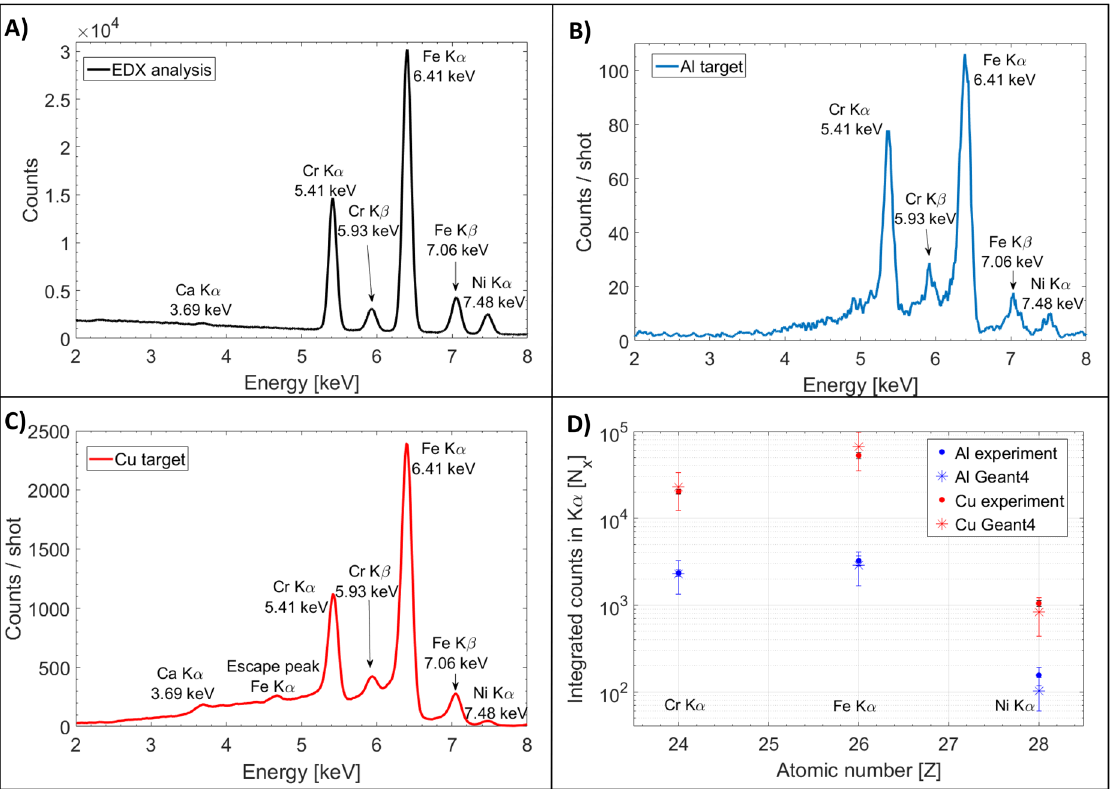
Figure 3. Stainless steel sample analysis. ( A ) EDX spectrum; ( B , C ) X-ray spectra obtained by a single shot irradiation, using the laser-based sources produced with a low Z (Al, blue) and higher Z (Cu, red) target respectively. ( D ) Measured integrated number of counts in the respective Fe, Ni and Zn K α peaks (presented in dots) obtained from the spectra depicted in ( B , C ). Geant4 simulation results are presented with